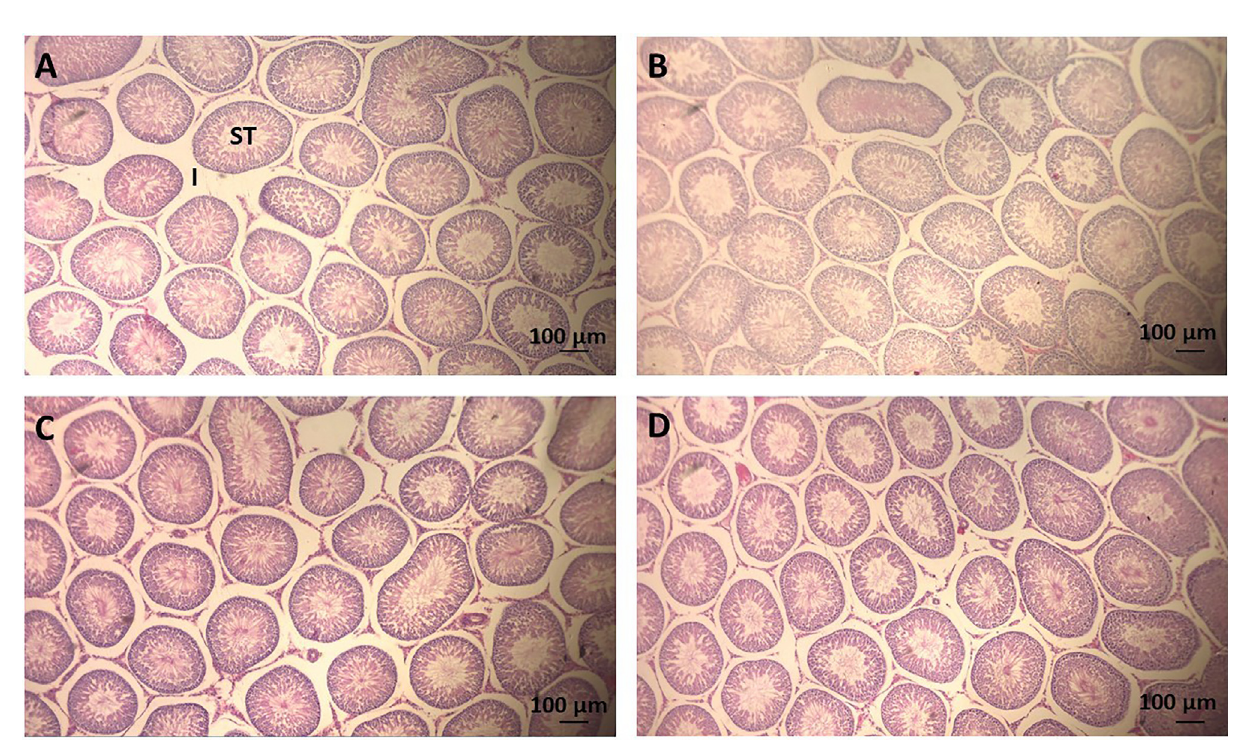
FIGURE 2 | Photomicrography of sections of seminiferous tubules (ST) of adult rats (PND 140) of the F1 generation. Scale = 100 m m, hematoxylin-eosin stain. (A) CTR group, treated with corn oil; (B) TCS 0.8 group, treated with triclosan at a dose of 0.8 mg/kg; (C) TCS 2.4 group, treated with triclosan at a dose of 2.4 mg/ kg; and (D) TCS 8.0 group, treated with triclosan at a dose of 8.0 mg/kg. ST, seminiferous tubule; I,